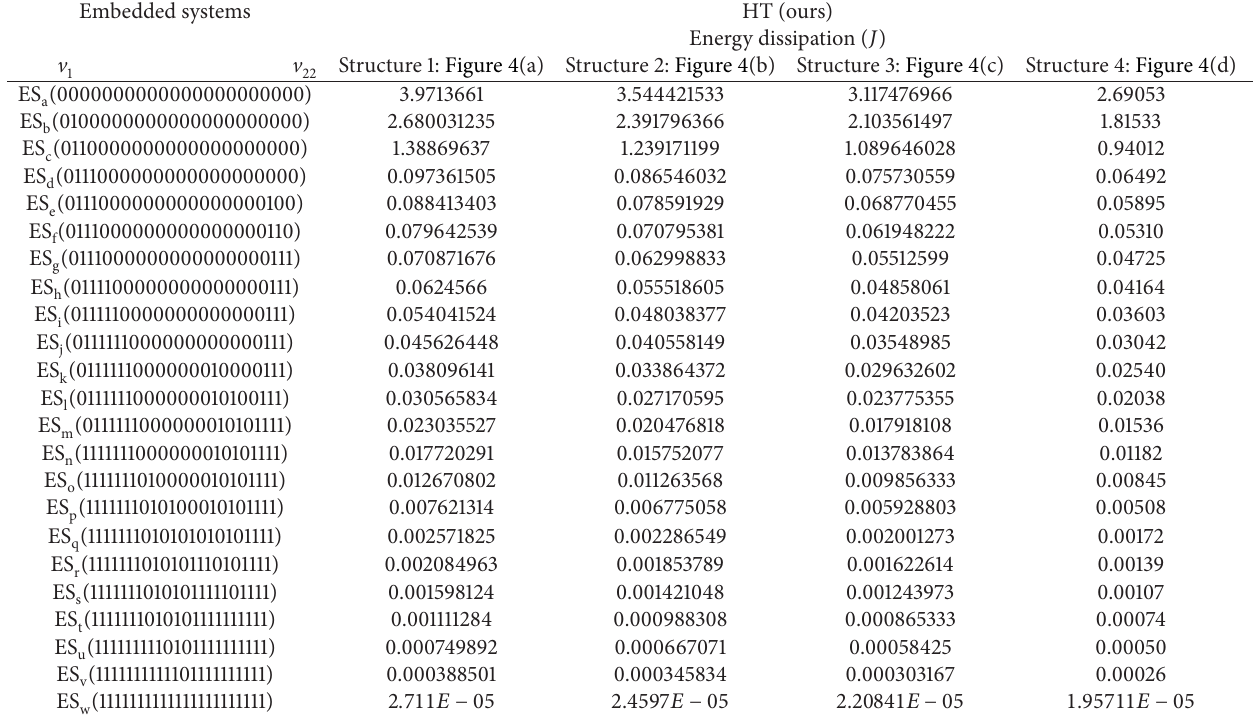
v Structure 1: Figure 4(a) Structure 2: Figure 4(b) Structure 3: Figure 4(c) Structure 4: Figure 22